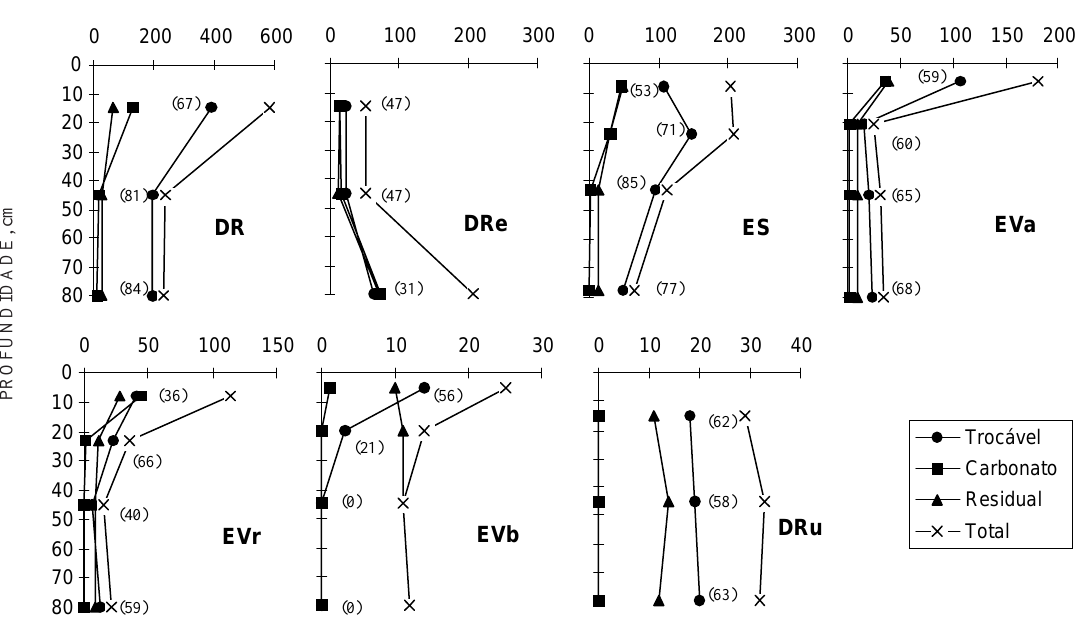
Figura 3. Formas químicas e teores de Cd no solo nos diversos locais e profundidades amostradas. Os números entre parênteses representam a percentagem do teor trocável do elemento em relação ao total. Legenda: ver figura 2.